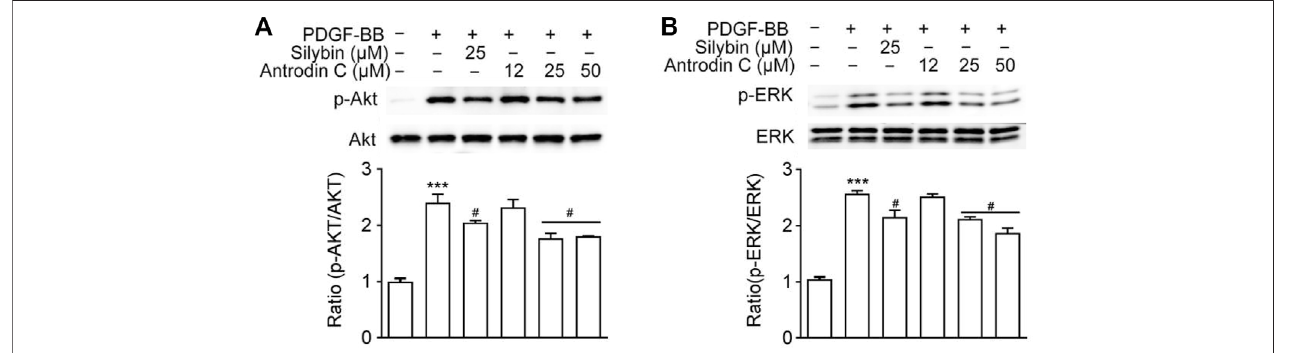
FIGURE5| EffectsofAntrodinConthePDGF-BB-inducedsignalingpathway. (A,B) CFSC-8BcellsweretreatedwithAntrodinC(12 – 50 μ M)for2 handtheninduced byPDGF-BB for 1 h,and totalcellularextractswereprepared andsubjected toWestern blotanalysistomeasurethelevelsofphosphorylatedAKTand ERK.TotalAKTand ERK were used for normalization. Data represent means ± SD ( n = 3), *** p < 0.001 compared with control; # p < 0.05 compared with PDGF-BB treated